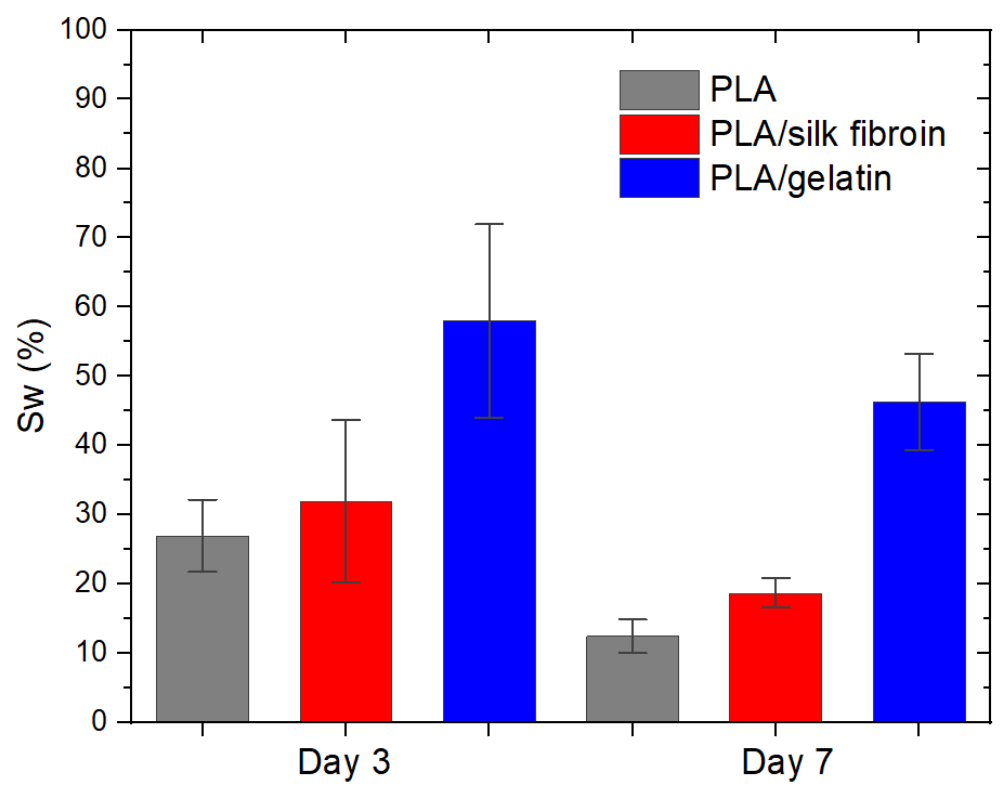
Figure 9. Swelling percentage of the electrospun PLA and modified PLA scaffolds on day 3 and day 7 after incubation in saline solution.